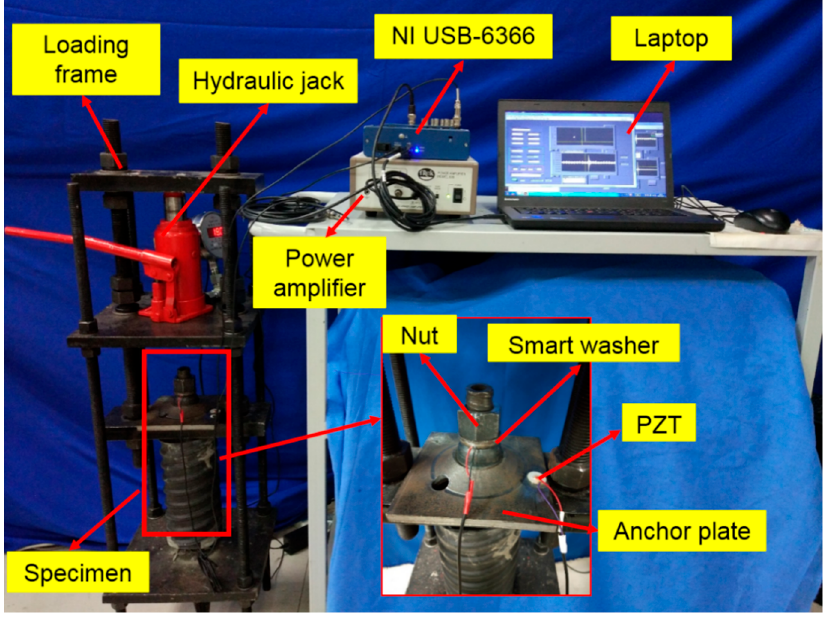
Figure 3. The experimental setup of pre-load monitoring of a rock bolt specimen.